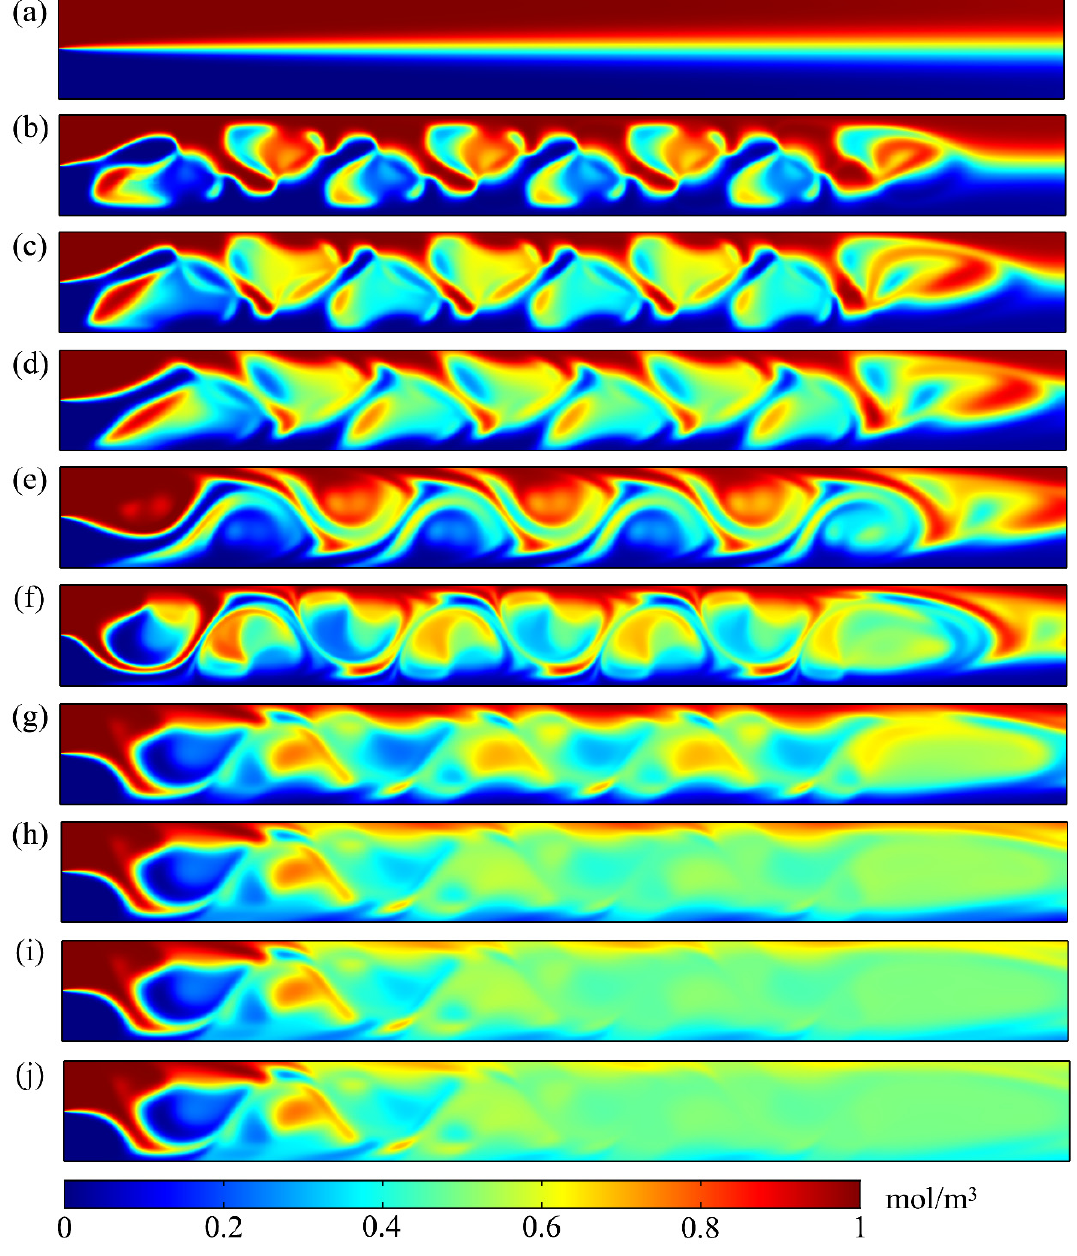
Figure 5. Concentration-distribution evolution of D–D section in microchannel at 10 different moments during 4 cycles: ( a ) t = 0 T, ( b ) t = 1/4 T, ( c ) t = 3/8 T, ( d ) t = 1/2 T, ( e ) t = 5/8 T, ( f ) t = 3/4 T, ( g ) t = 1 T, ( h ) t = 2 T, ( i ) t = 3 T, and ( j ) t = 4 T. Peak-to-peak value of applied potential was V 0 = 1 V, electric-field frequency was f = 5 Hz, and inlet mean velocity was U m = 2 × 10 –4 m/s. Length was L o = 10 μ m, width was W o = 10 μ m, and spacing was S o = 10 μ m of the virtual electrode. Aspect ratio of the microchannel was W c / H c = 1. Color legend, concentration distribution from 0 to 1 mol/m 3 .